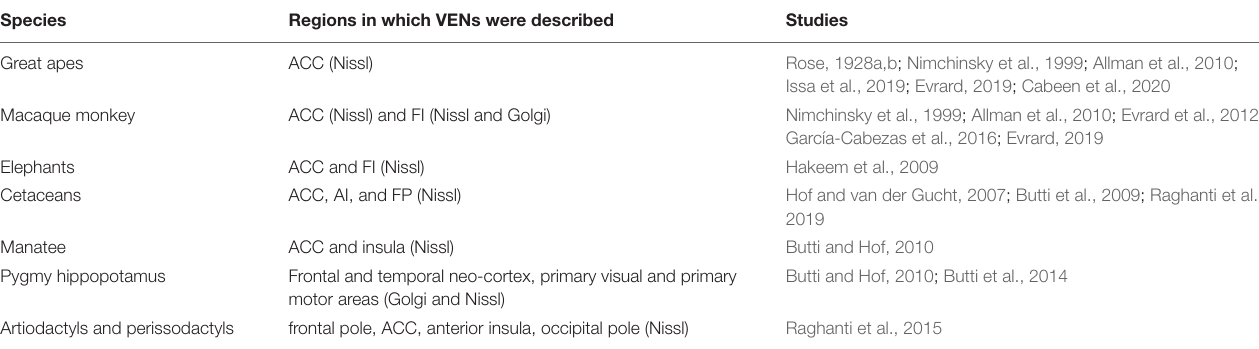
TABLE 1 | Descriptions of von Economo neurons (VENs) in non-human species.